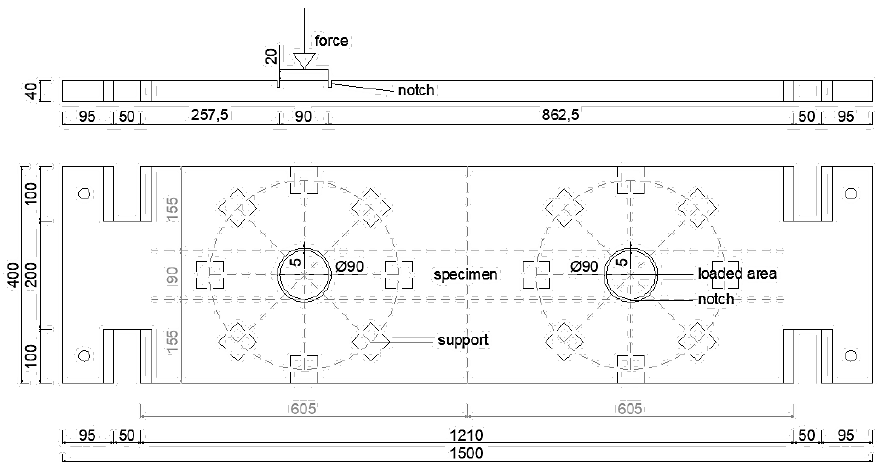
Figure 9. Experimental design (dimensions in mm).